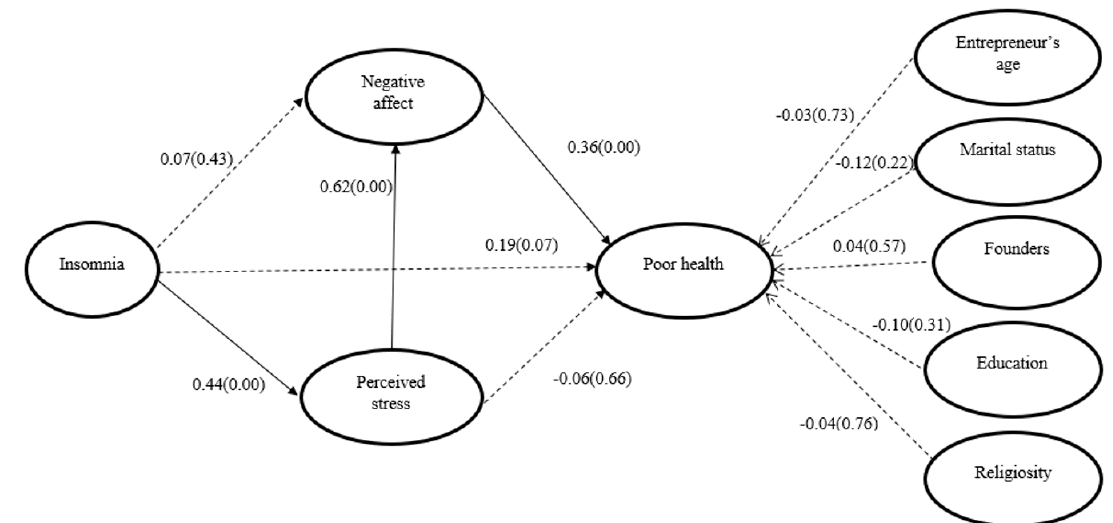
Figure 1. The Structural Equation Model (Standardized Parameter Estimates Are Shown with p Values in